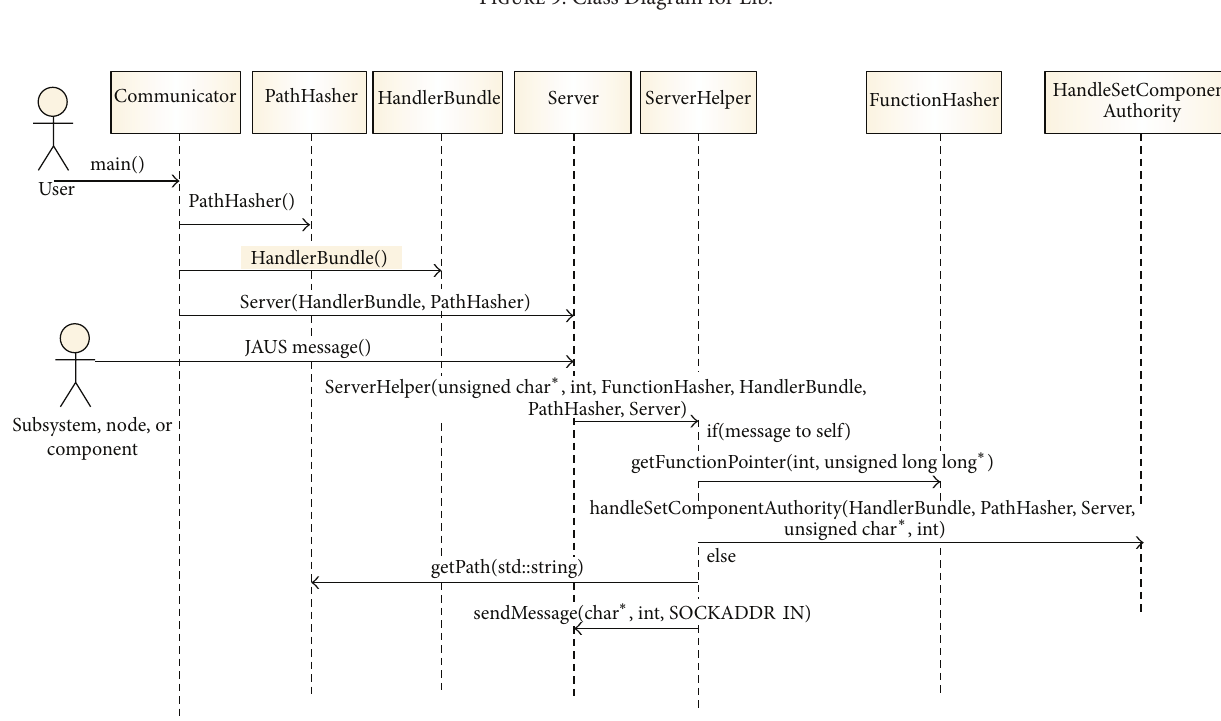
Figure 9: Class Diagram for Lib.